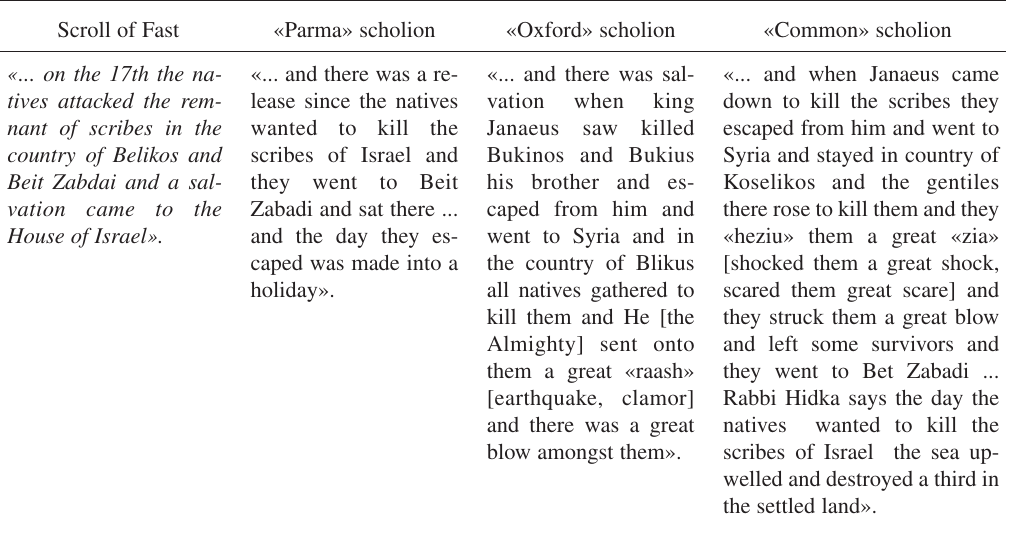
Table III. Comparison between the original text of the «Scroll of Fast» and the three versions of the scholion to the 33rd entry. Scroll of Fast «Parma» scholion «Oxford» scholion «... on the 17th the na- tives attacked the rem- nant of scribes in the country of Belikos and Beit Zabdai and a sal- vation came to the House of